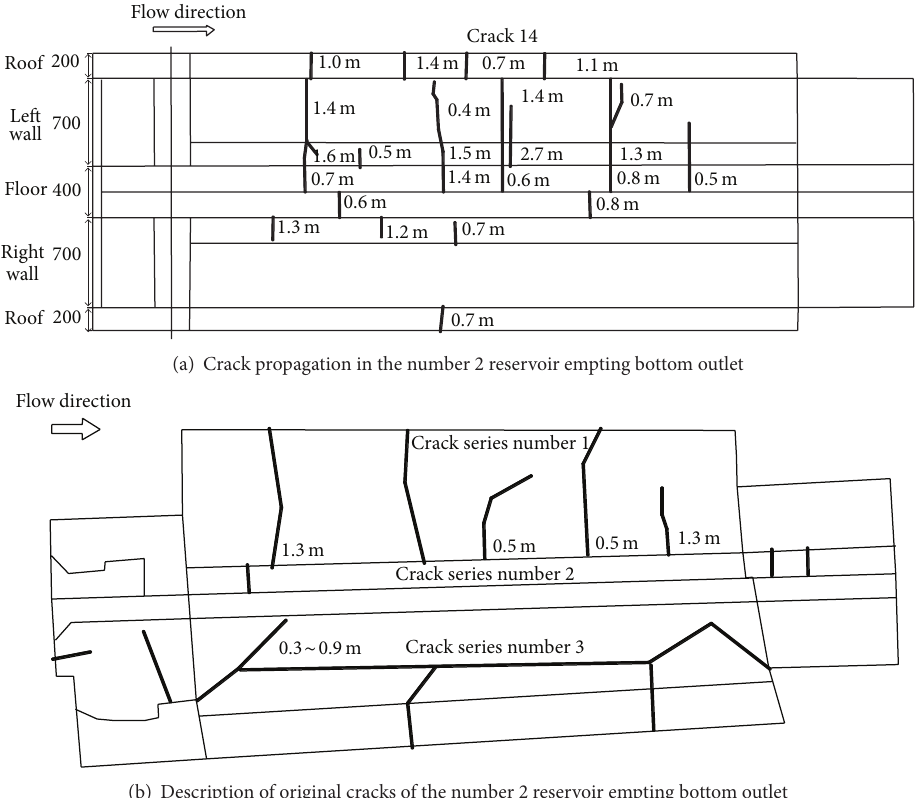
Figure 3: Schematic sketch of outlet cracking in the number 2 reservoir empting bottom outlet of the Goupitan arch dam.